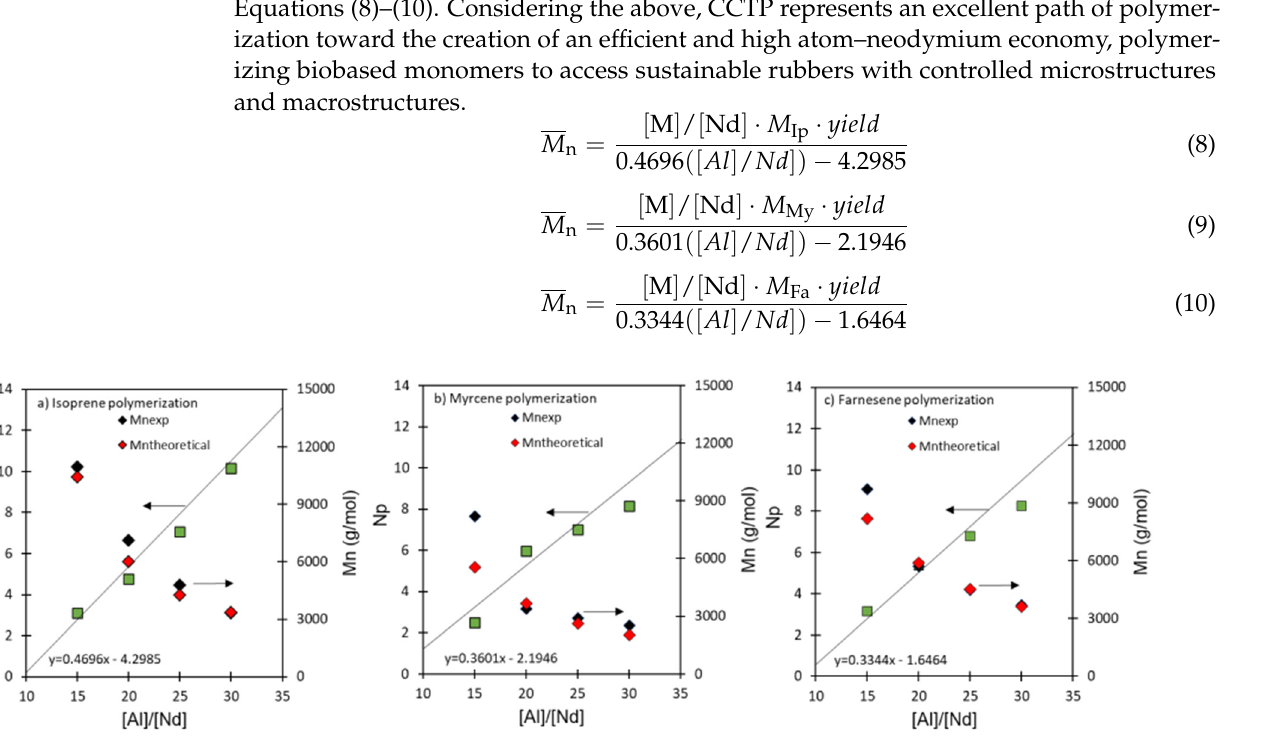
Figure 8. M n , M ntheoretical , and N P as functions of [Al]/[Nd] ratios for ( a ) Ip: entries Ip-3 to Ip-6, ( b ) My: entries My-3 to My-6, and ( c ) Fa: entries Fa-3 to Fa-6, polymerizations initiated by NdV 3 /Al( i -Bu) 2 H/Me 2 SiCl 2 in cyclohexane at 60 °C.